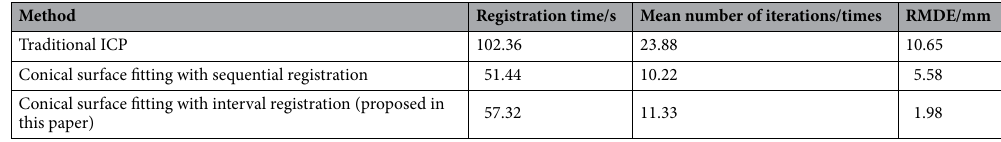
Table 5. Comparison of ICP registration algorithms.